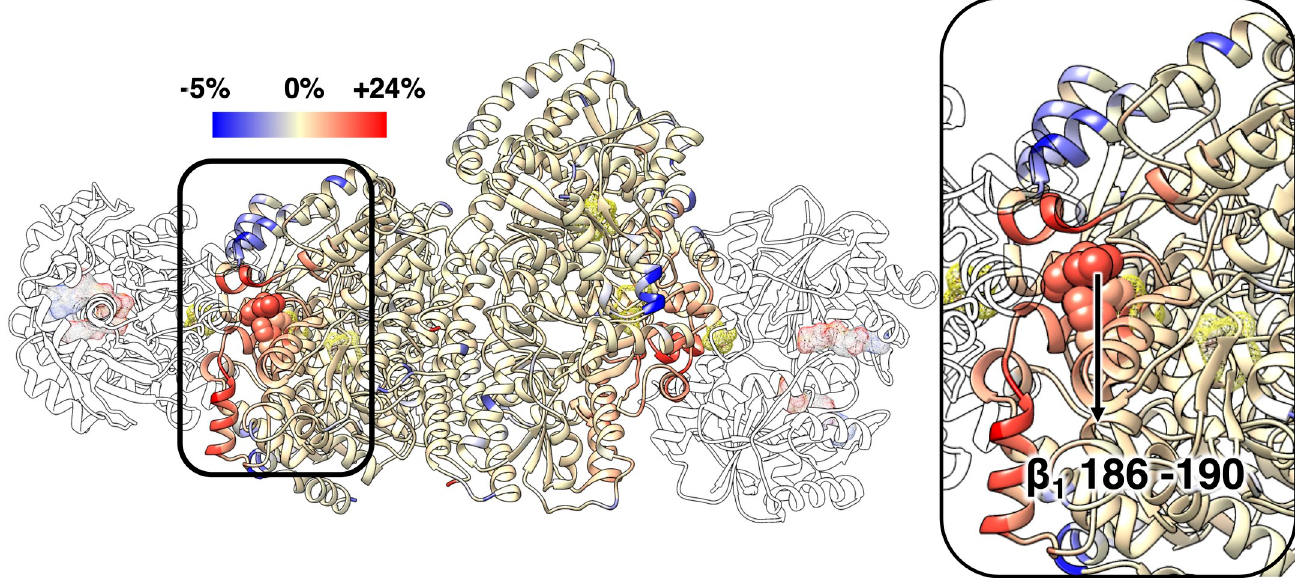
Fig 4. Change in RMSF of the MoFe protein upon ATP hydrolysis. The change is shown as deviation of the RMSF of the MoFe protein in the ADP-bound complex relative to the ATP-bound complex reported as a color scale and is projected on the ribbon representation of the protein. The positive changes, whereby the ADP-bound complex shows larger flexibility than the ATP-bound complex, are shown in red, and the negative values are shown in blue. For clarity of representation, the RMSF change for the Fe proteins is not color-coded. The ATP analogues, [4Fe-4S] clusters, P-clusters, and FeMo-co are shown in mesh surface. Residues 186–190 in β 1 are highlighted as space-filling structures (spheres). Residues at Fe protein/MoFe protein interface with large RMSF change upon ATP hydrolysis appear in orange or red.